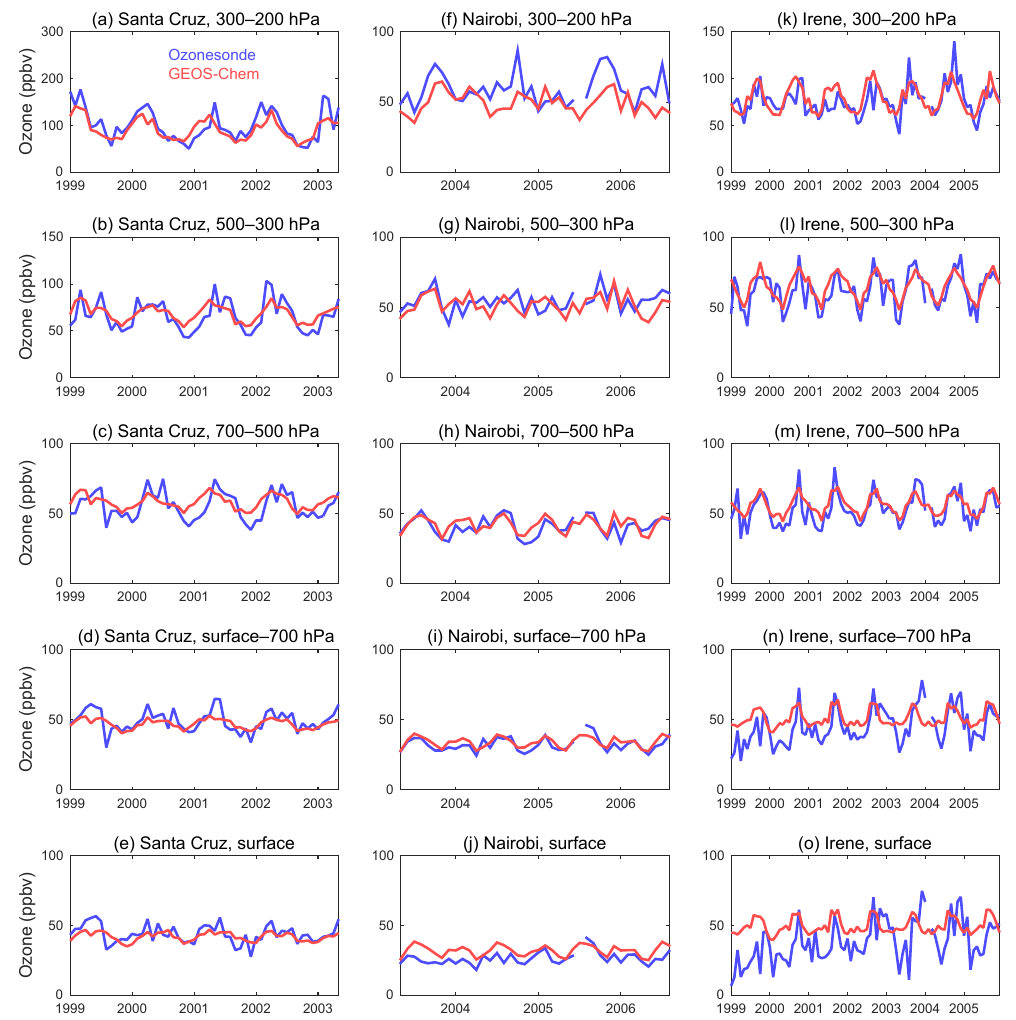
Figure 3. Comparison of the time series of monthly ozone between GEOS-Chem simulations (red line) and ozonesonde measurements (blue line) for layers averaged over 300–200hPa (a, f, k) , 500–300hPa (b, g, l) , 700–500hPa (c, h, m) , surface–700hPa (d, i, n) , and at the surface layer (e, j, o) at Santa Cruz (a–e) , Nairobi (f–j) , and Irene (k–o) in Africa, respectively.